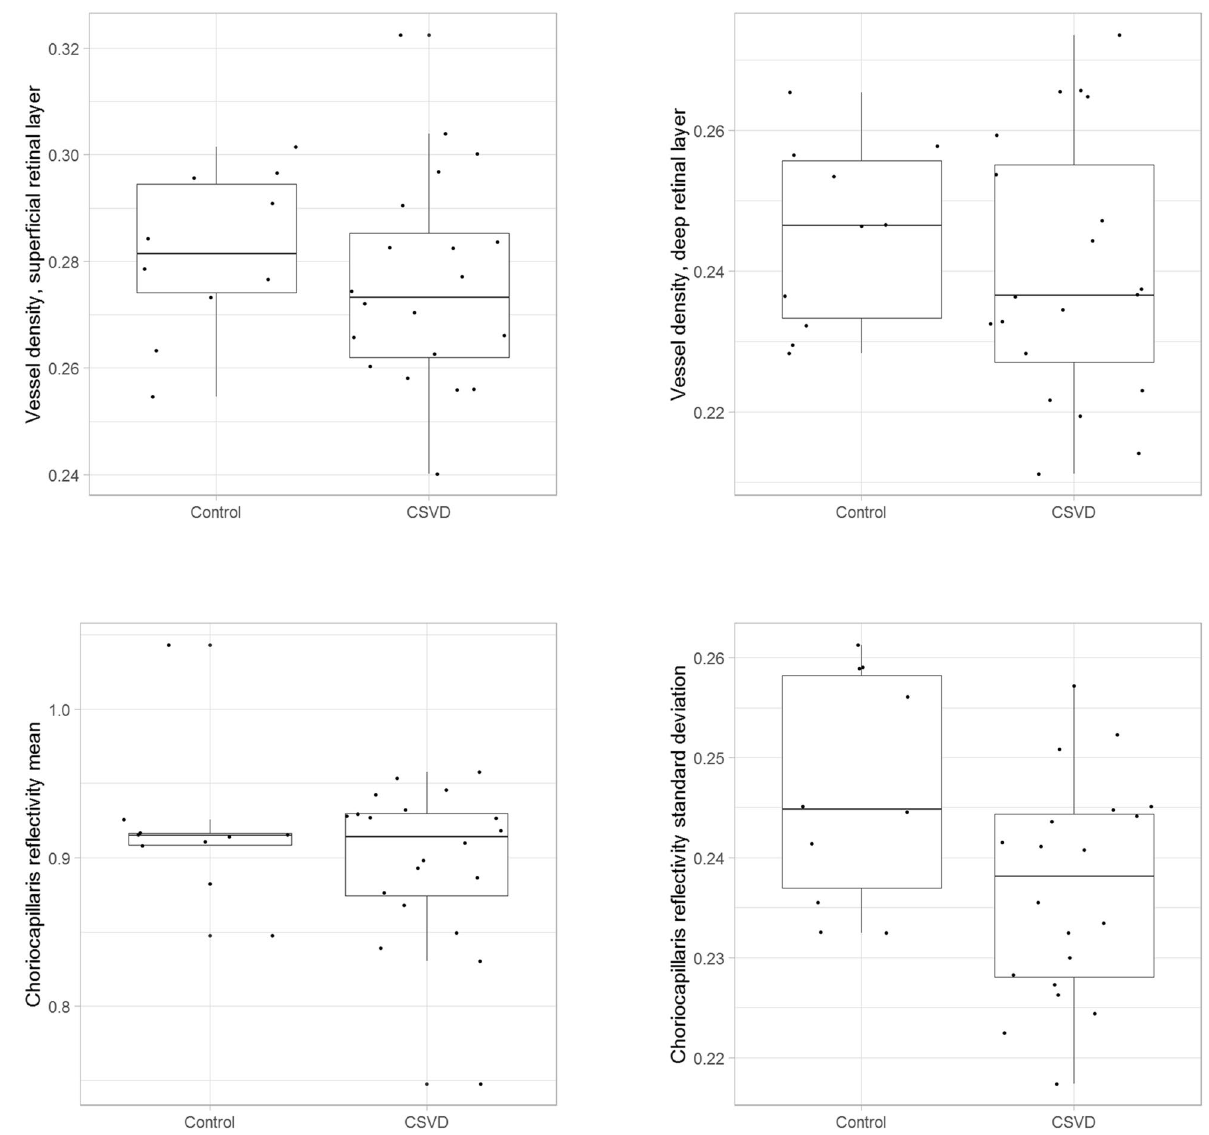
Figure 2. Boxplots showing the distributions of OCT-A parameters which represent the vessel plexus investigated in participants with CSVD and